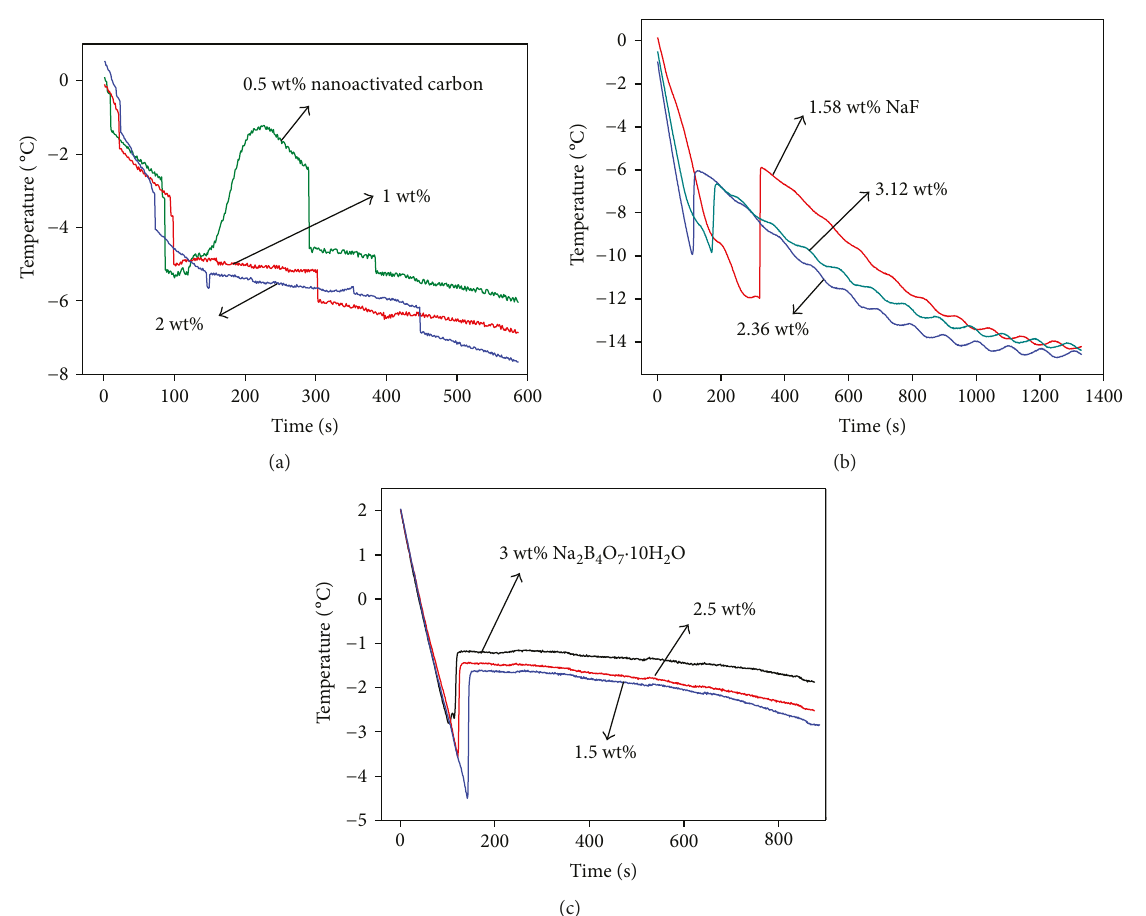
Figure 9: (a), (b), and (c) represent step cooling curves of adding three di ff erent kinds of nucleating agent (nanoactivated carbon, NaF, and